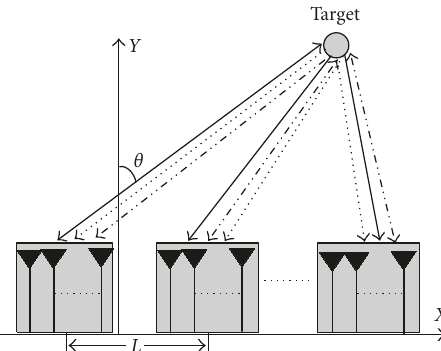
Figure 1: MIMO radar with separated